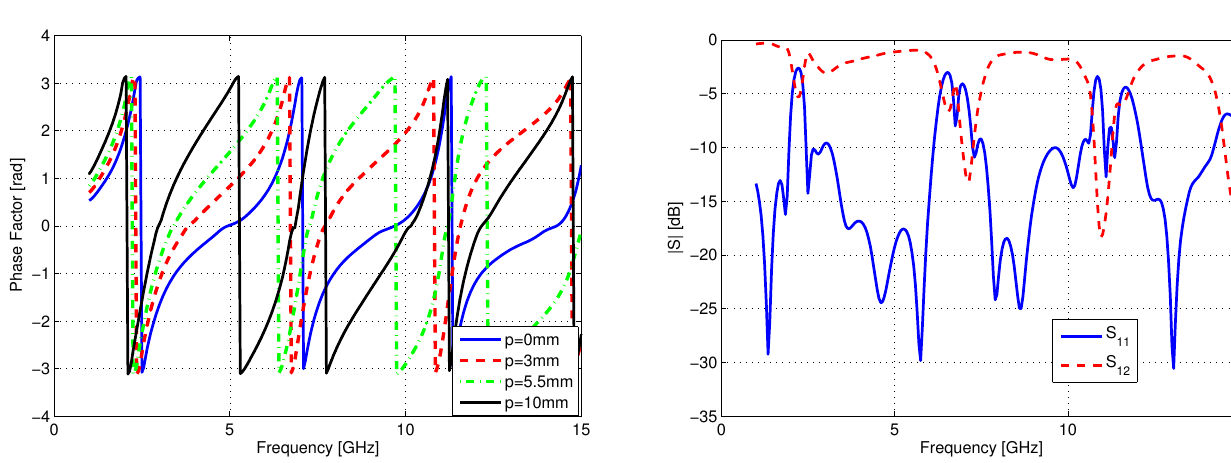
Figure 5: Phase factor for different cell lengths p .